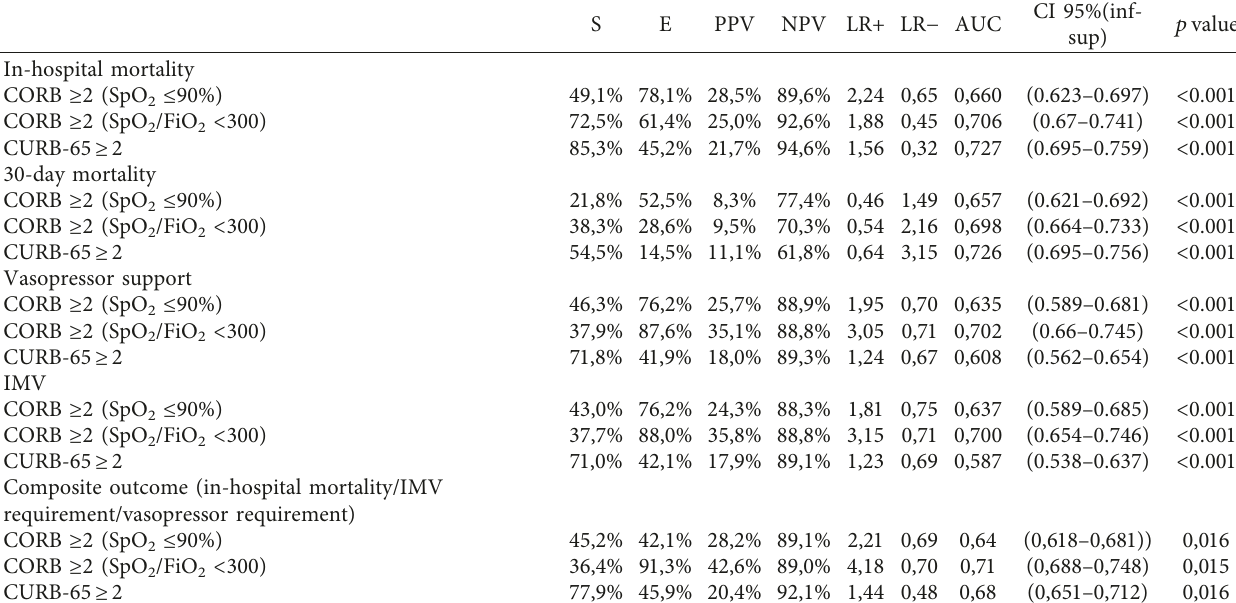
Table 3: Performance of CORB and CURB-65 scores for mortality, vasopressor support, and IMV outcomes. S